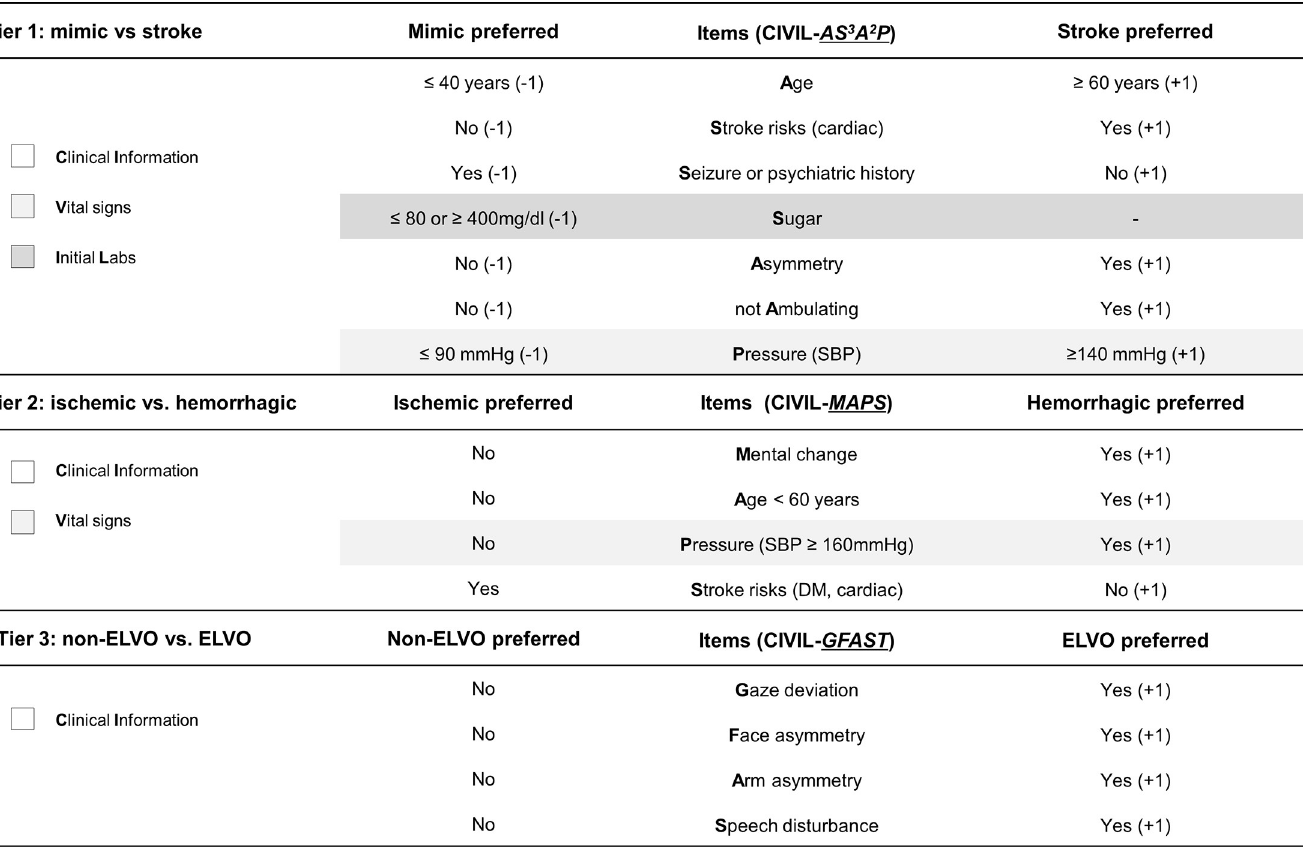
Fig 3. Descriptive comparison of various early stroke recognition scales. CIVIL = Clinical Information, Vital signs, and Initial Labs, CPSS = Cincinnati Prehospital Stroke Scale, LAPSS = Los Angeles Prehospital Stroke Screen, ROSIER = Recognition Of Stroke In the Emergency Room.